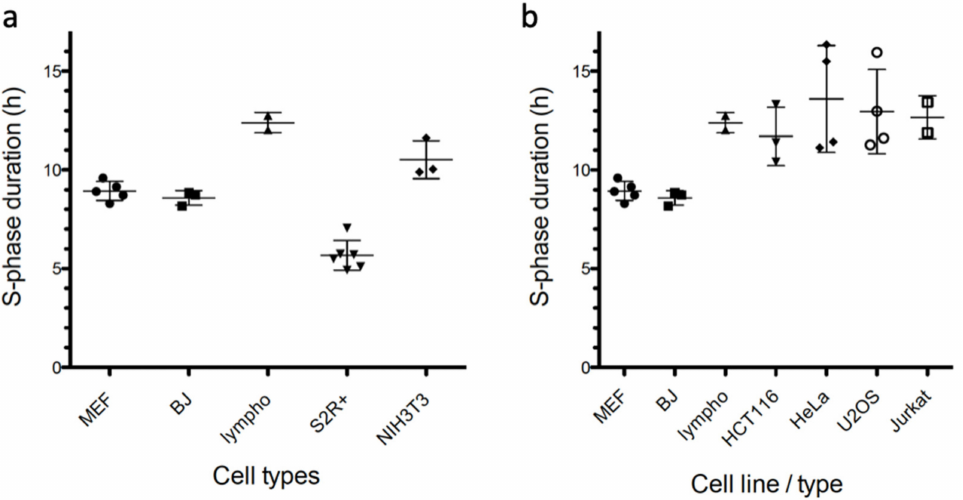
Figure 4. S-phase duration in different cell lines. ( a ) Proliferating cultures of mouse embryonic fibroblasts (MEF), human primary fibroblasts (BJ), human lymphocytes (lympho), Drosophila cell line (SR2R+) and immortalized mouse fibroblasts (NIH3T3) were treated as indicated and SPD measured. Each dot represents an independent biological replicate. ( b ) S-phase durations obtained for primary (MEFs, BJs, lymphocytes) and cancer-derived (HCT116, HeLa, U2OS, Jurkat)